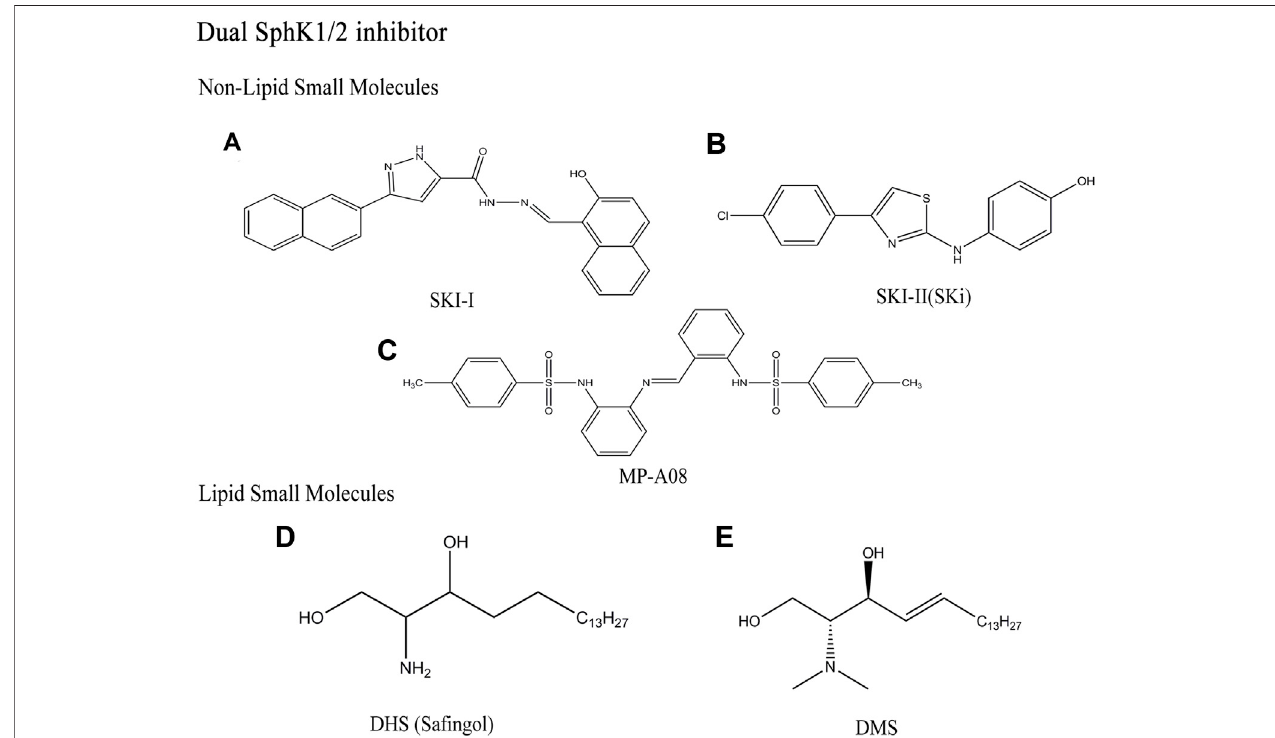
FIGURE 4 | Structures of dual SphK1/2